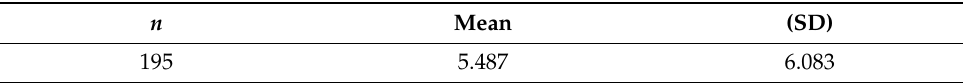
Table 4. PHQ-9 descriptive